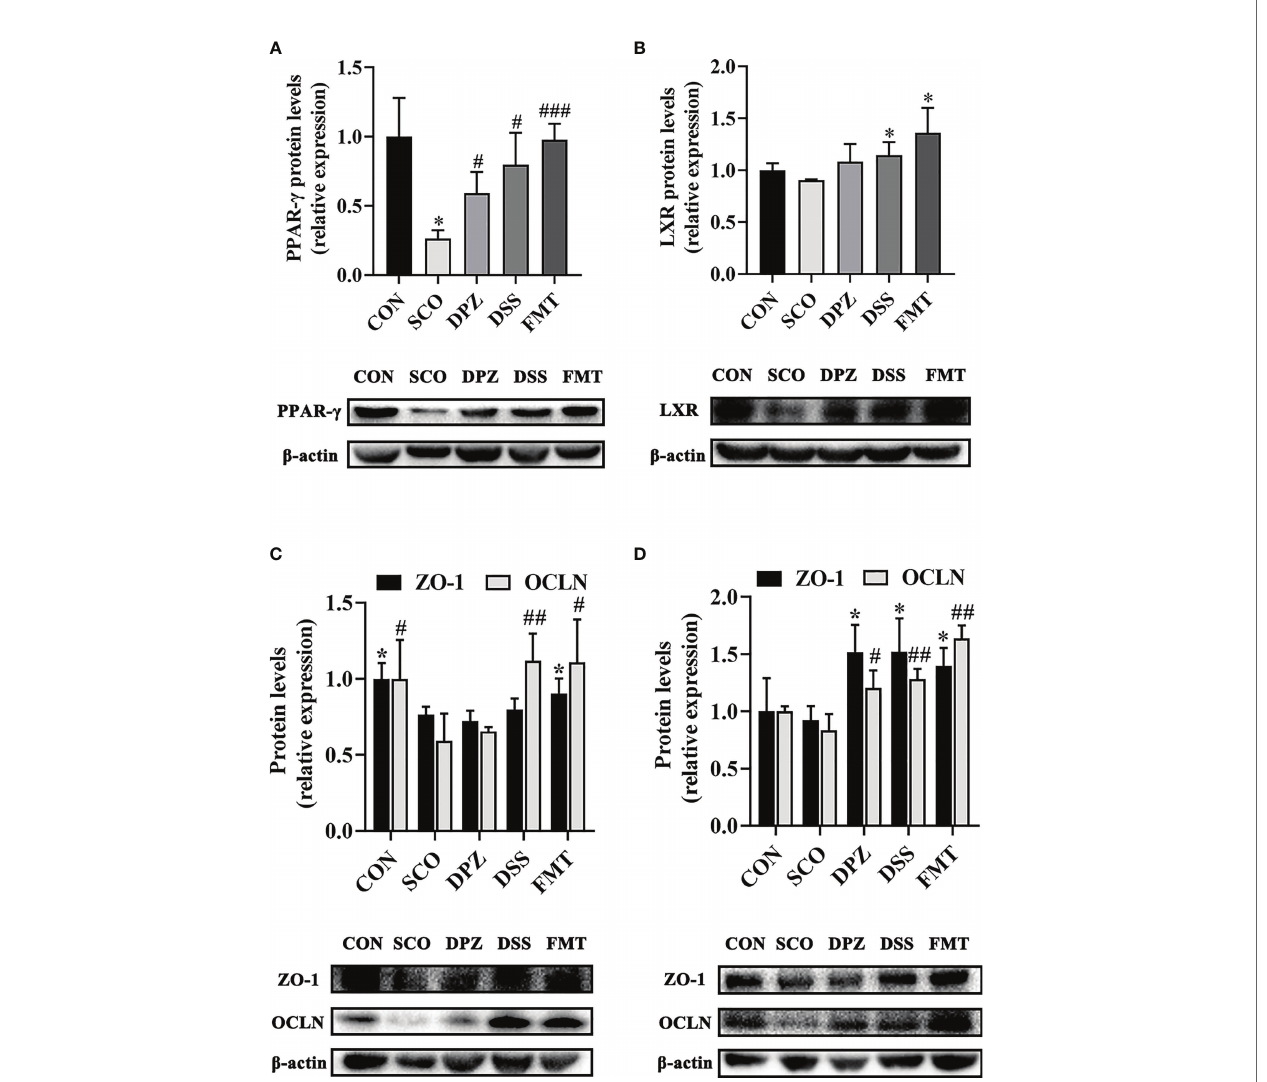
FIGURE 11 | Western blot analysis shows the expression of PPAR- g (A) , ZO-1 and OCLN (C) in gut and LXR (B) together with ZO-1 and OCLN (D) in hippocampus tissues of each experimental group. Densitometry analysis of the Western blot band of PPAR- g , LXR, ZO-1 and OCLN used Quantity One (n = 3). The relative ratio of PPAR- g , LXR, ZO-1 and OCLN was represented by densitometric analysis. * p < 0.05, vs. CON; # p < 0.05, ### p < 0.001 vs. SCO in PPAR- g R; * p < 0.05 vs. SCO in LXR; *p < 0.05 vs. SCO in ZO-1, # p < 0.05, ## p < 0.01 vs. SCO in